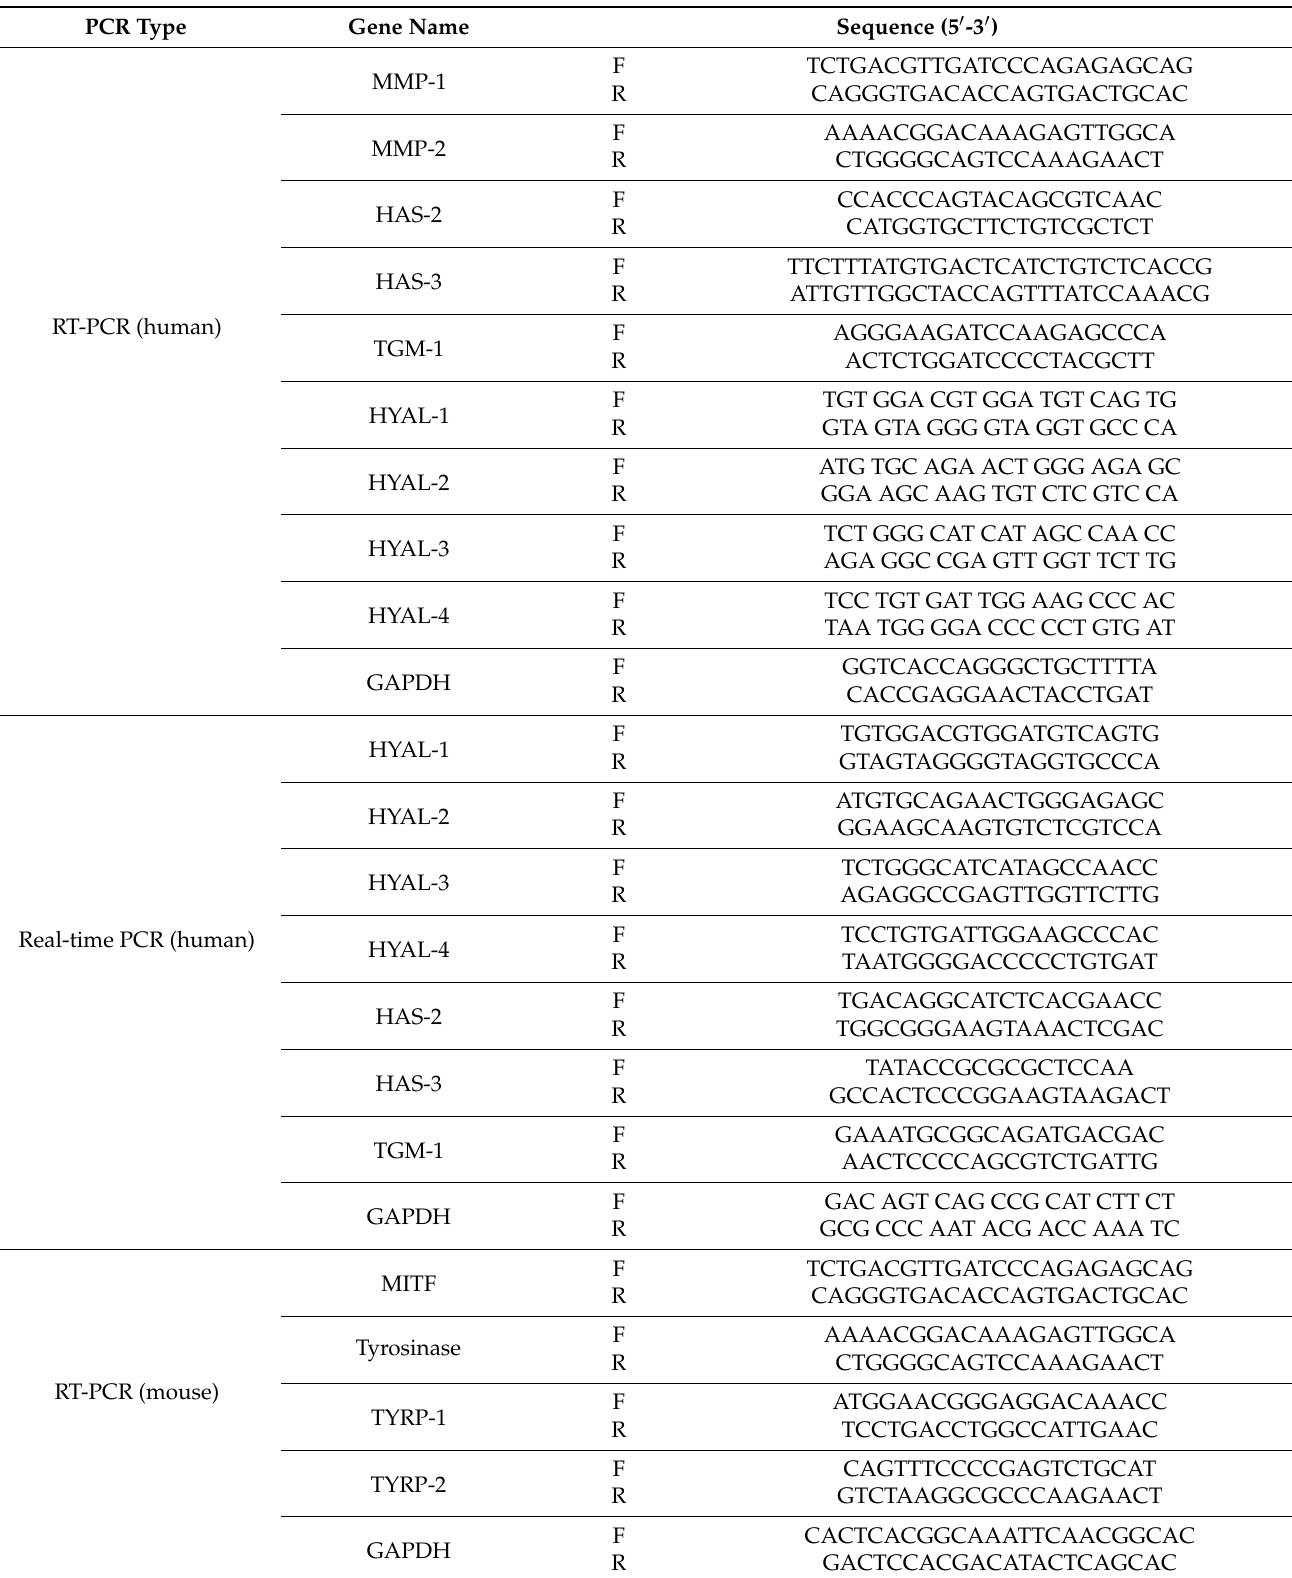
Table 3. Sequences of primers used for